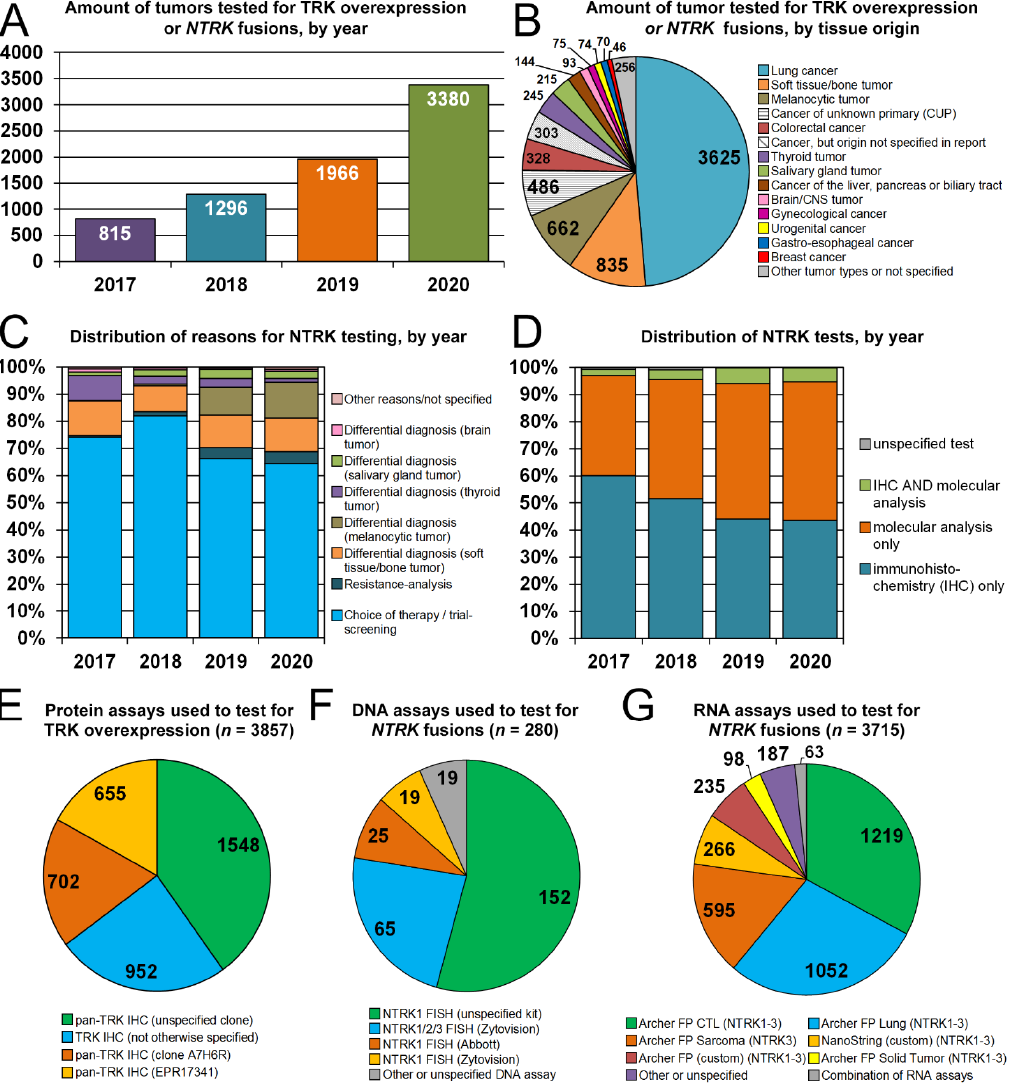
Figure 1. Indications and number of TRK overexpression and/or NTRK fusions testing in the Netherlands, 2017–2020. ( A , B ) Number of tumors tested for TRK overexpression or NTRK fusions, by year ( A ) and tissue origin ( B ). ( C ) Distribution of reasons for NTRK /TRK testing, by year. ( D ) Distribution of NTRK tests, by year. ( E – G ) Protein ( E ), DNA ( F ) and RNA ( G ) assays used to test for TRK overexpression or NTRK fusions. Abbreviations: CNS, central nervous system; CTL, comprehensive thyroid and lung; FISH, fluorescence in situ hybridization; FP, FusionPlex.